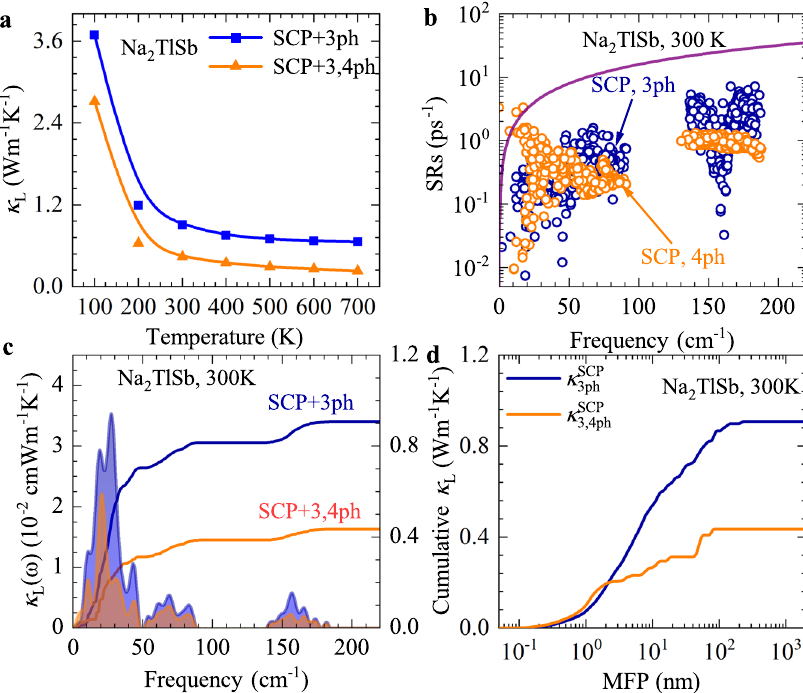
Fig. 2 Phonon transport properties. a The calculated temperature-dependent κ L from 100 to 700 K by using SCP + 3ph and SCP + 3,4ph, respectively. b The calculated 3ph (blue empty circles) and 4ph (orange empty circles) scattering rates (SRs) in the SCP approximations. The purple line denotes 1/ τ ph = ω ph /2 π , that is, the scattering rates equal to phonon frequencies. c The κ L spectrum (The fi lled area below the lines) and cumulative κ L at 300 K by using SCP + 3ph and SCP + 3,4ph, respectively. d Same as c but for the maximum mean free path (MFP) cumulative κ L at 300